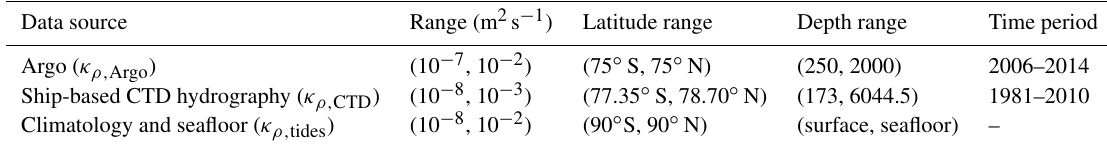
Table 1. The latitude and depth ranges of each observationally derived product from a parameterization used in this study. The longitude range for each dataset spans (180 ◦ E, 180 ◦ W). Also listed are the time period of the observations each product is based on and the range of values in each product (to the nearest order of magnitude in units of m 2 s − 1 ).